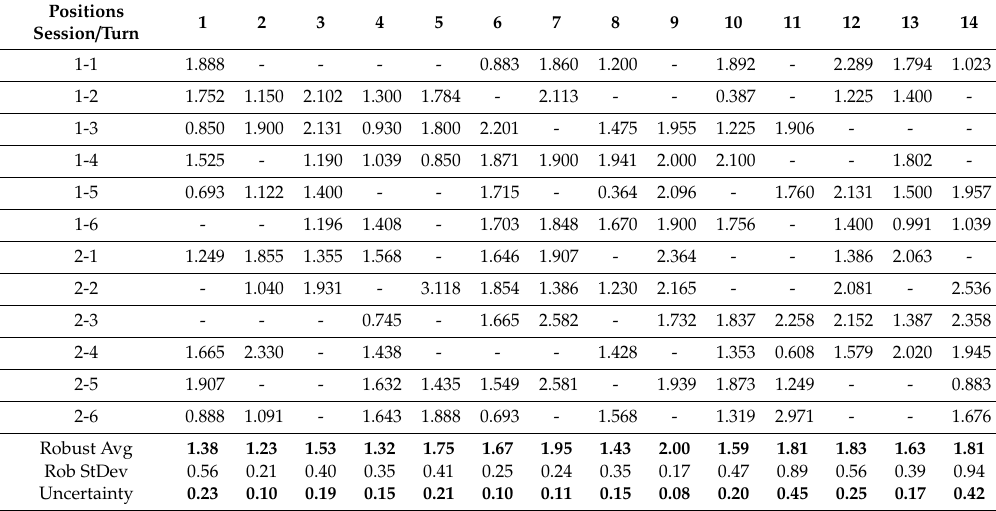
Table 3. Measurement samples in E LTE_RS mode for all positions with their average values, standard deviation, and uncertainty.